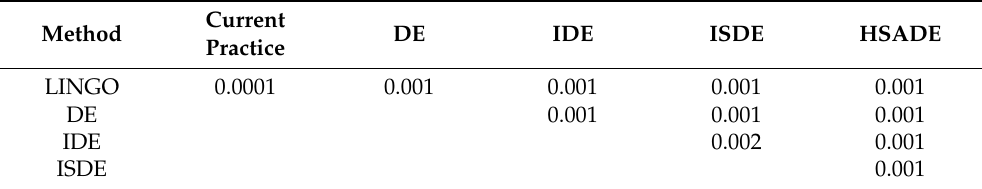
Table 5. Statistical test results of the total cost obtained from Table